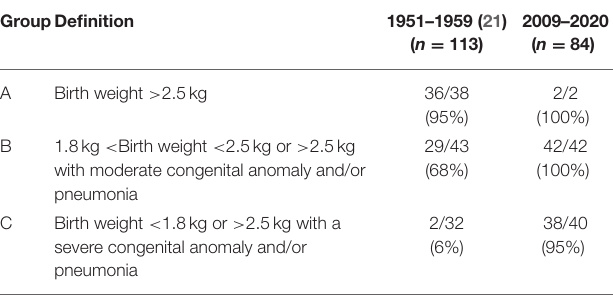
TABLE 3 | Mortality risk assessment I.